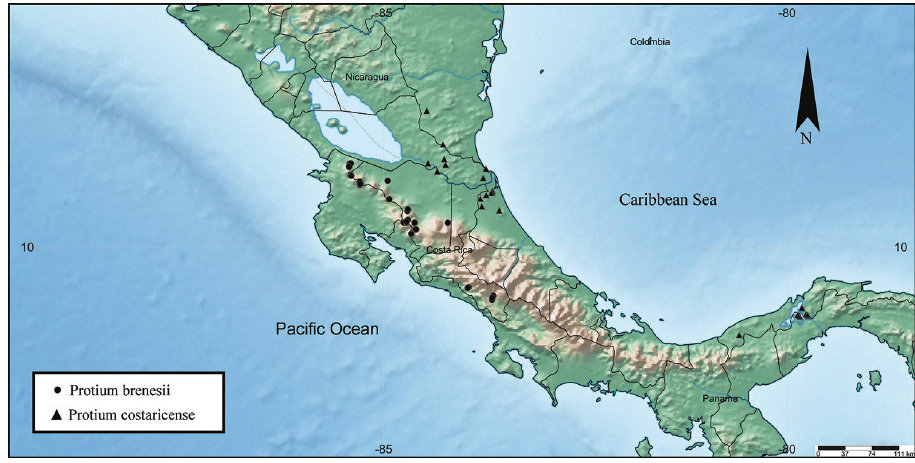
Figure 9. Distribution of Protium brenesii and P. costaricense